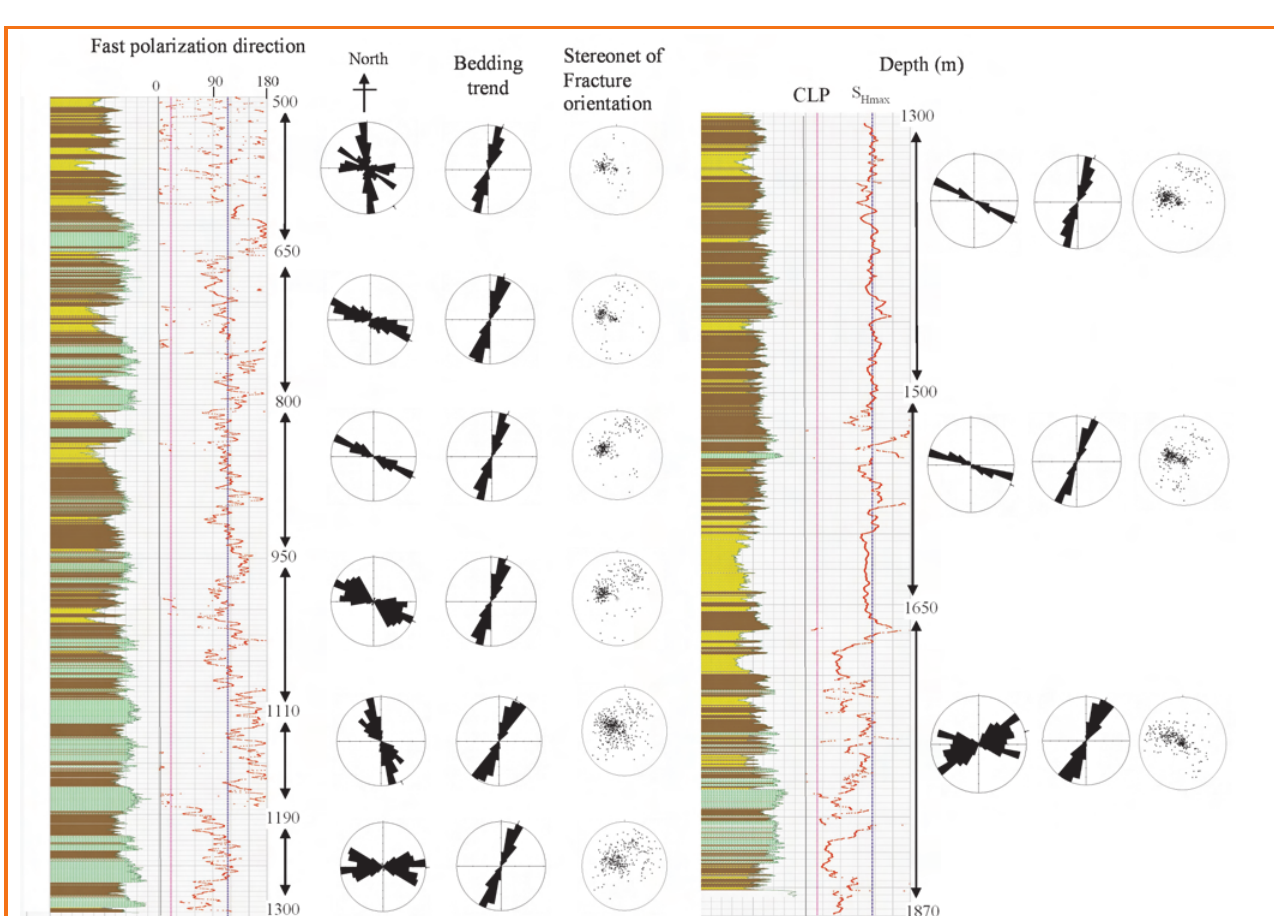
Figure 5. Comparison of the fast-shear polarization direction with bedding trend determined from borehole images and fracture orientations measured from core images. Azimuths of the Chelungpu fault (CLP, 020) and maximum horizontal stress (S hmax , 115) in central Taiwan determined from earthquake focal mechanisms (Yeh et al., 1991) are shown for references.